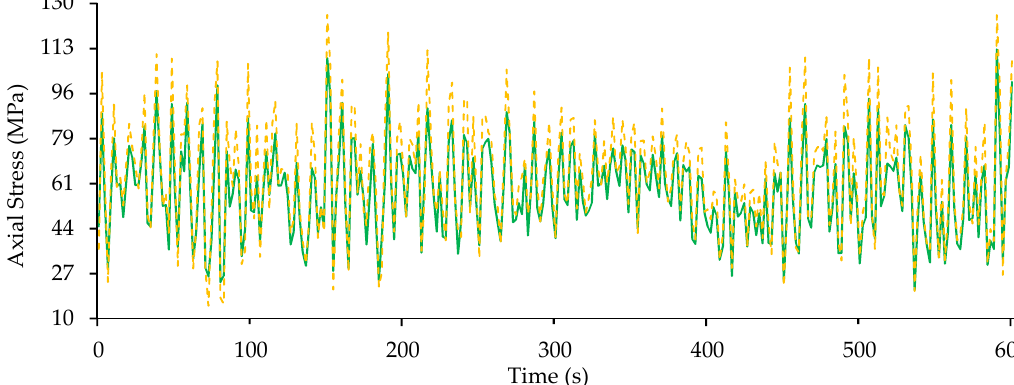
Figure 20. Registered stress series on the dynamic analysis for the monopile, with the axial stresses for Pt 0 (solid line) and the axial stresses for Pt 7 (dashed line).